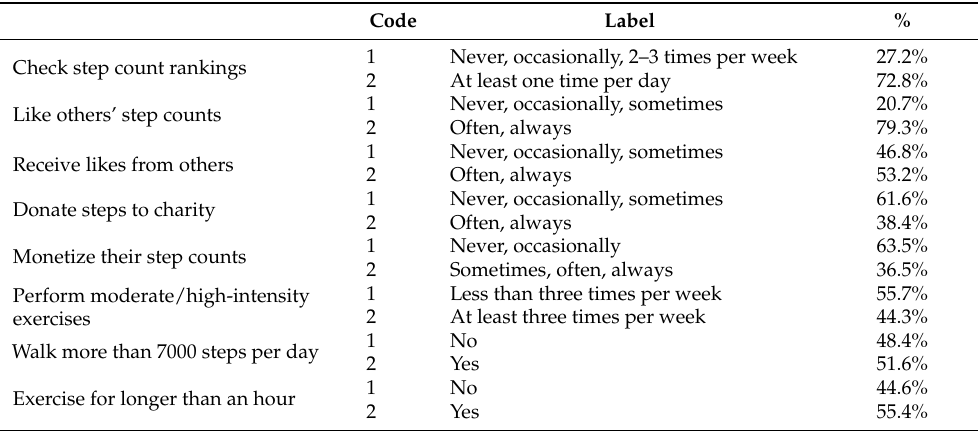
Table 2. Indicators for latent class analysis (N = 632).